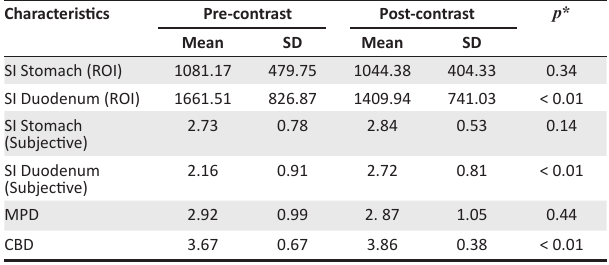
TABLE 3: Effect of pineapple juice as a negative contrast agent in the evaluation of pancreatobiliary structures by magnetic resonance cholangiopancreatography.